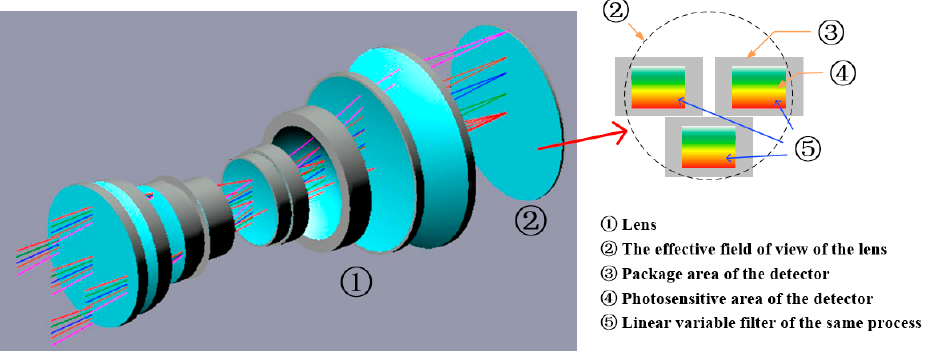
Figure 3. Structure diagram of optical system.